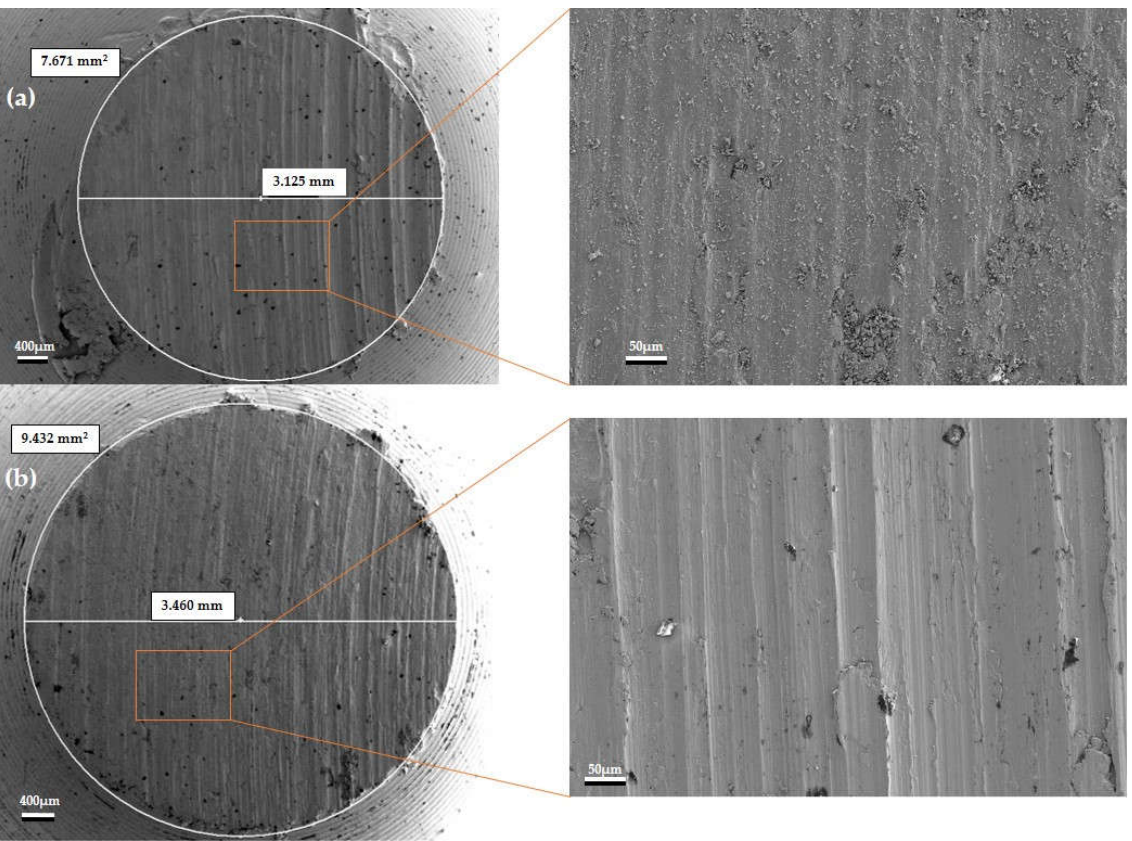
Figure 12. FESEM images of worn pin surface ( a ) of counterpart pin for g-C 3 N 4 /MoS 2 (9 wt.%) nanocomposite-coated disc and ( b ) of counterpart pin for MoS 2 coated disc.